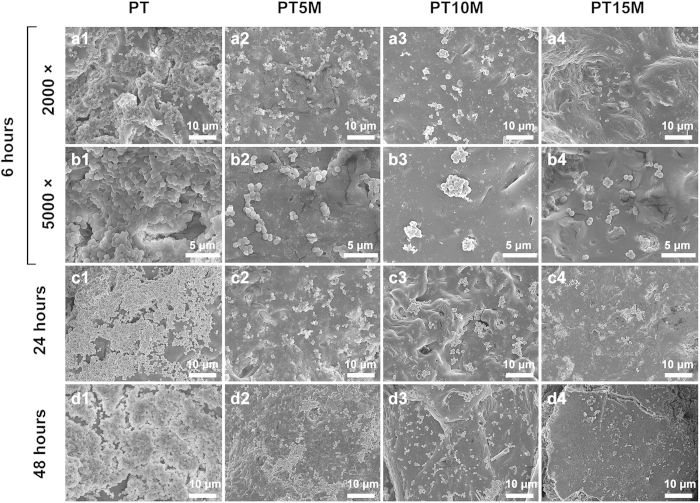
Representative SEM images showing bacterial adhesion and biofilm formation on surfaces of specimens.